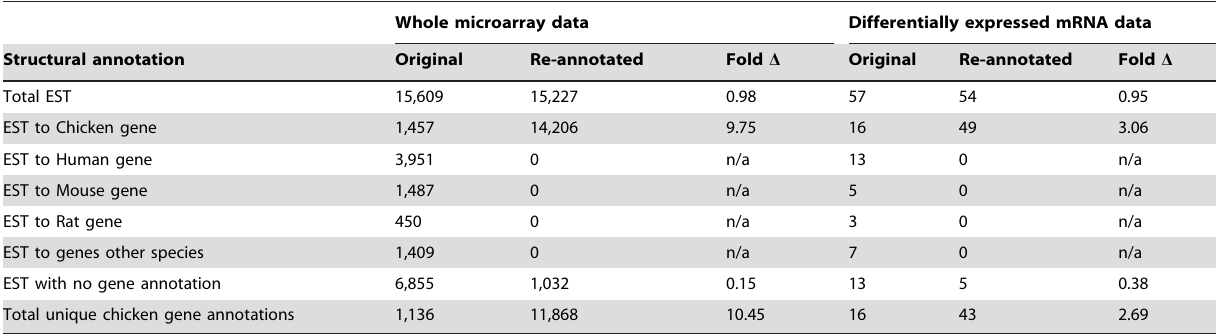
Table 1. Structural re-annotation